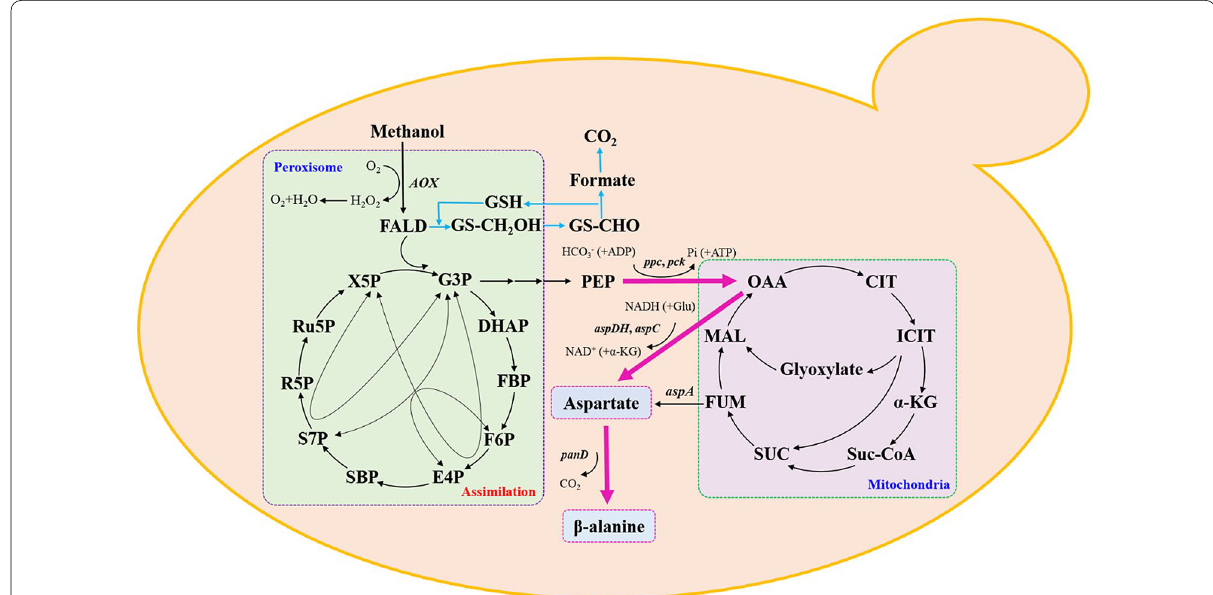
Fig. 1 The biosynthesis pathway designed in P. pastoris for the production of β-alanine from methanol. AOX : gene encoding alcohol oxidase; ppc : gene encoding PEP carboxylase; pck : gene encoding PEP carboxykinase; aspDH : gene encoding aspartate dehydrogenase; aspC : gene encoding aspartate aminotransferase; aspA : gene encoding aspartate ammonia-lyase; panD : gene encoding aspartate-α-decarboxylases; FALD: formaldehyde; X5P: xylulose-5-phosphate; G3P: glyceraldehyde-3-phosphate; DHAP: dihydroxyacetone phosphate; FBP: fructose-1,6-bisphosphate; F6P: fructose-6-phosphate; E4P: erythrose-4-phosphate; SBP: sedoheptulose-1,7-bisphosphate; S7P: sedoheptulose-7-phosphate; R5P: ribose-5-phosphate; Ru5P: ribulose-5-phosphate; PEP: phosphoenolpyruvate; Glu: glutamate; OAA: oxaloacetate; CIT: Citrate; ICIT: isocitrate; α-KG: α-ketoglutarate; Suc-CoA: succinyl-CoA; SUC: succinate; FUM: fumarate; MAL: